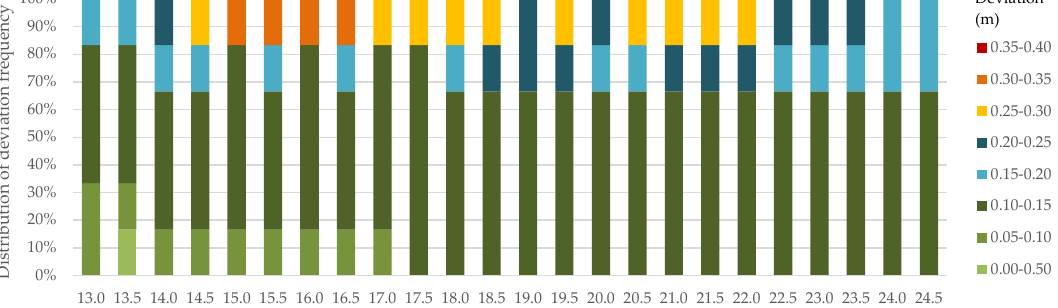
Figure 11. Distribution of deviation frequency for right-hand-side trajectories.